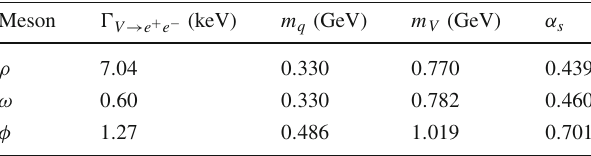
Table 1 The lepton decay width (cid:9) V → e + e − , the constituent quark mass m q , meson mass m V and the strong coupling parameter α s for ρ , ω and φ [24,31–34]